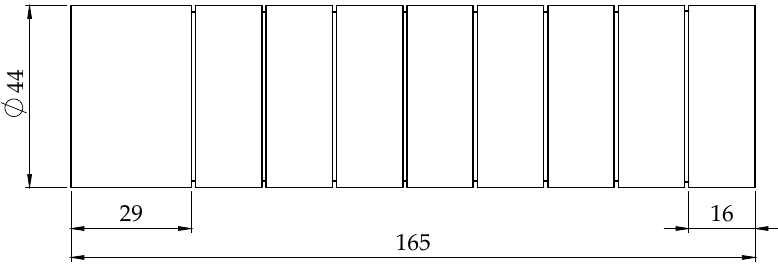
Figure 1. Profile and dimensions of the machined workpiece (units in mm).